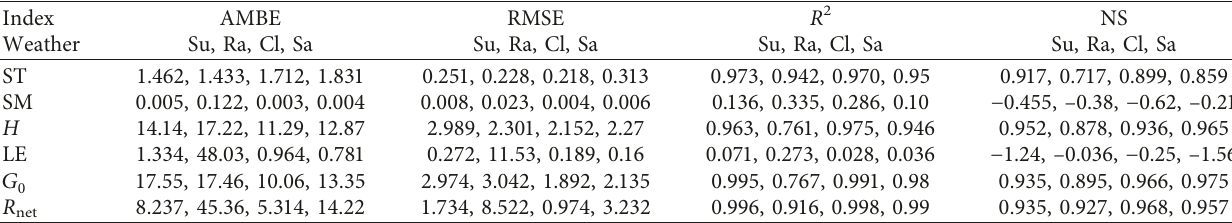
Table 3: Statistical analysis of the simulation results.